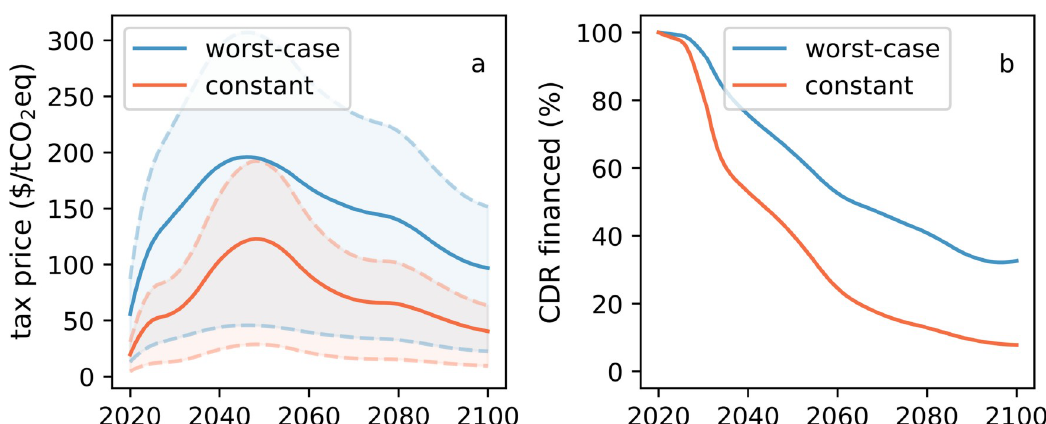
Fig 4. Tax price and percentage of total CDR financed by it. a) Time development of agricultural non-CO 2 emissions tax price under the constant emissions scenario (orange) and the worst-case emissions scenario (blue). Solid lines are tax prices for a best estimate of future CDR cost by $150/tCO 2 removed whereas the dotted lines encompass a possible range of CDR costs between $35-235/tCO 2 . b) Percentage of the total CDR (i.e., SSP1-2.6 CDR plus extra CDR to offset additional agricultural emissions) financed via the tax on agricultural emissions under the constant (orange) and worst-case (blue) emission